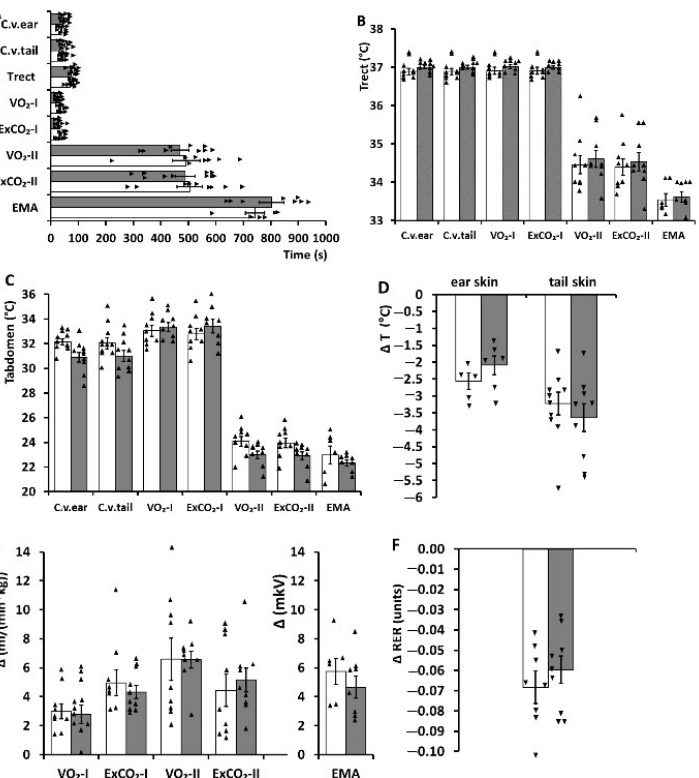
Figure 1. Parameters of thermoregulatory responses to rapid cooling in hypertensive ISIAH rats subjected to the peripheral ion channel TRPM8 activation by menthol (application of a 1% suspension in saline to the skin) and control hypertensive ISIAH rats (application of saline). ( A ) Latency periods (s) of thermoregulatory reactions during the rapid cooling. Legend: C.v.ear, the constrictor reaction of ear skin vessels; C.v.tail, the constrictor reaction of tail skin vessels; T rect, the decrease in rectal temperature; VO 2 -I, an oxygen consumption increase in the first phase of the metabolic response; ExCO 2 -I, an increase in carbon dioxide excretion in the first phase of the metabolic response; VO 2 -II, an oxygen consumption increase in the second phase of the metabolic response; ExCO 2 -II, an increase in carbon dioxide excretion in the second phase of the metabolic response; EMA, an increase in muscle electrical activity. ( B ) Threshold values of core body temperature (rectal; ◦ C) for the initiations of thermoregulatory responses during rapid cooling. Legend: the same as in ( A ). ( C ) Threshold values of the abdominal skin temperature ( ◦ C) for the initiations of thermoregulatory responses during rapid cooling. Legend: the same as in ( A ). ( D ) Maximum changes in heat loss parameters (changes in the ear and tail skin temperatures) during rapid cooling. ( E ) Maximum changes in the parameters of heat production during rapid cooling. Legend: the same as in ( A ). ( F ) Maximum changes in the respiratory exchange ratio during rapid cooling. Triangles represent the individual values of the parameters. In all panels, the data from control animals are represented by open bars, and data from the animals subjected to the peripheral ion channel TRPM8 activation with menthol are indicated by filled bars. Thermoregulatory responses were compared by the t -test (Statistica 8 software package). p -values are presented in Table